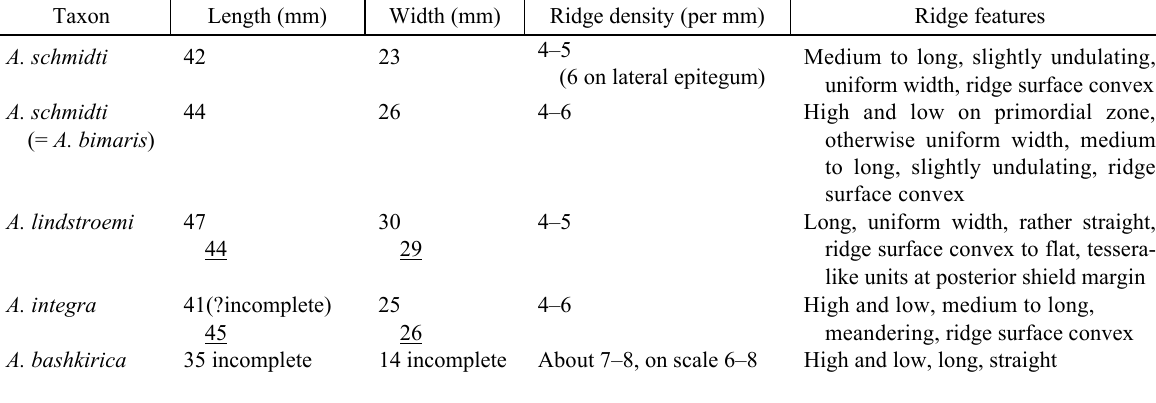
Table 1. Comparison of some data on four Archegonaspis species. The ridge features were chosen from the central epitegum behind the rostral field. Measurement and sculpture data are from Geinitz (1884), Kunth (1872), Lindström (1895), Denison (1964) and Novitskaya (1970, table 1, p. 112) complemented herein. Dorsal or ventral shields of A. bashkirica are not defined. Ventral measurements of A. lindstroemi and A. integra are underlined Taxon Length (mm) Width (mm) Ridge density (per